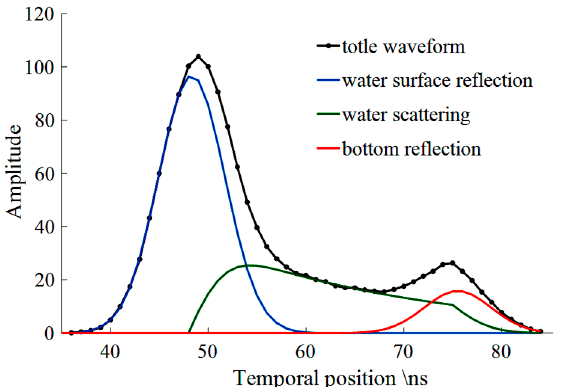
Figure 11. Simulation waveform.